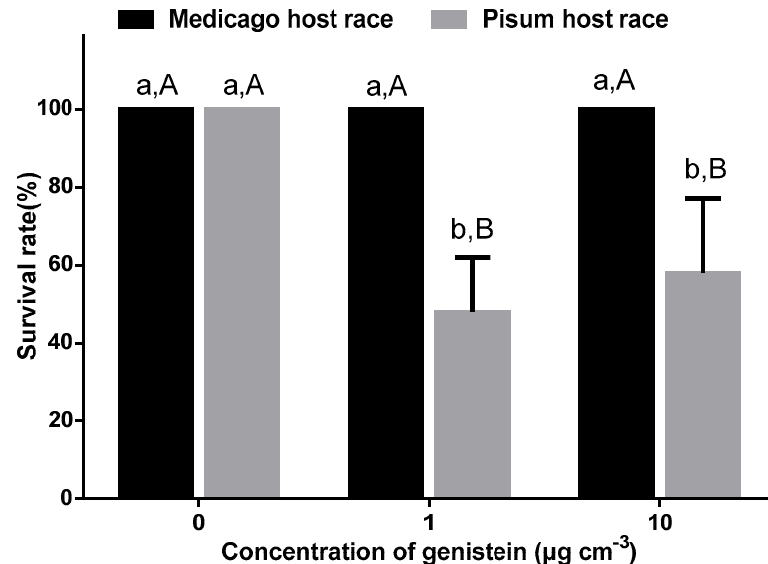
Figure 3. Survival rate of the two host races of Acyrthosiphon pisum fed on artificial diets with the application of different concentrations of genistein. Each value represents the mean ( ± SE) of five replicates. “0” indicates the diets without genistein, which were used as a control. Different uppercase letters indicate significant differences among the genistein treatments within the same host races, as determined by Tukey’s at p < 0.05. Different lowercase letters indicate significant differences between the two host races within the same genistein treatment, as determined by Student’s t -test at p < 0.05. 3.3. Transcriptomic Characteristics of the Two Host Races of A. pisum on M.